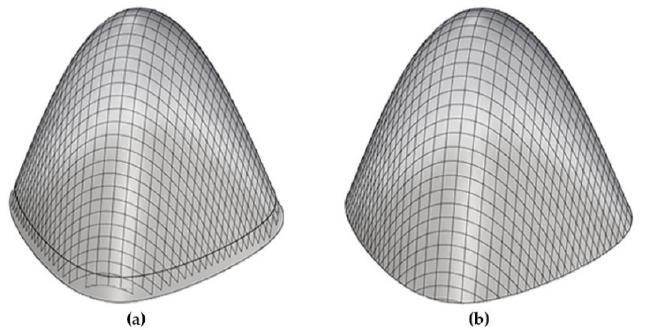
Figure 14. ( a ) Extended mesh and laths over the extended surface; ( b ) Trimmed mesh result over the test